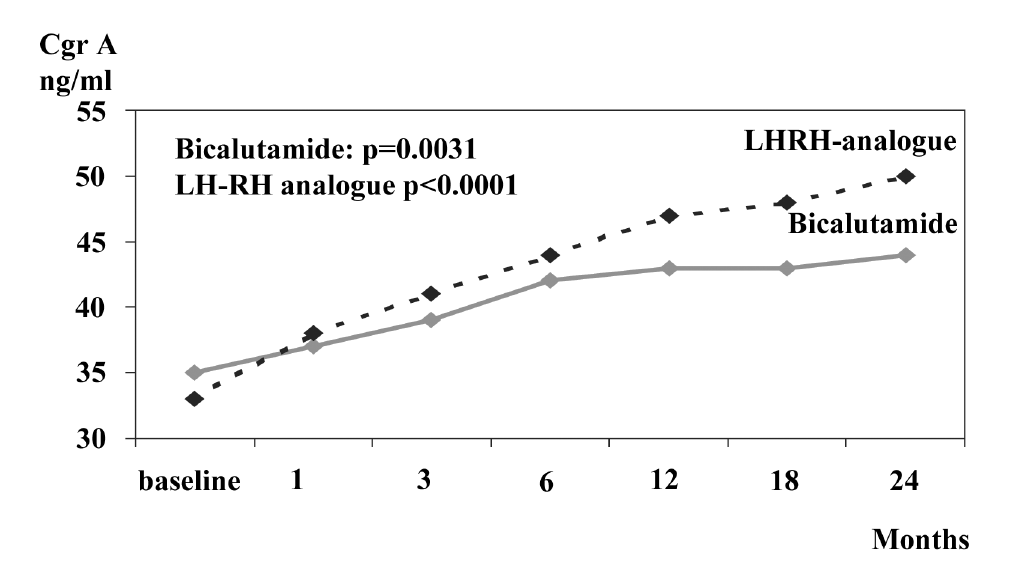
Figure 1 – Effect of castration therapy versus antiandrogen monotherapy on chromogranin A (CgA) expression in locally advanced prostate cancer (ref.